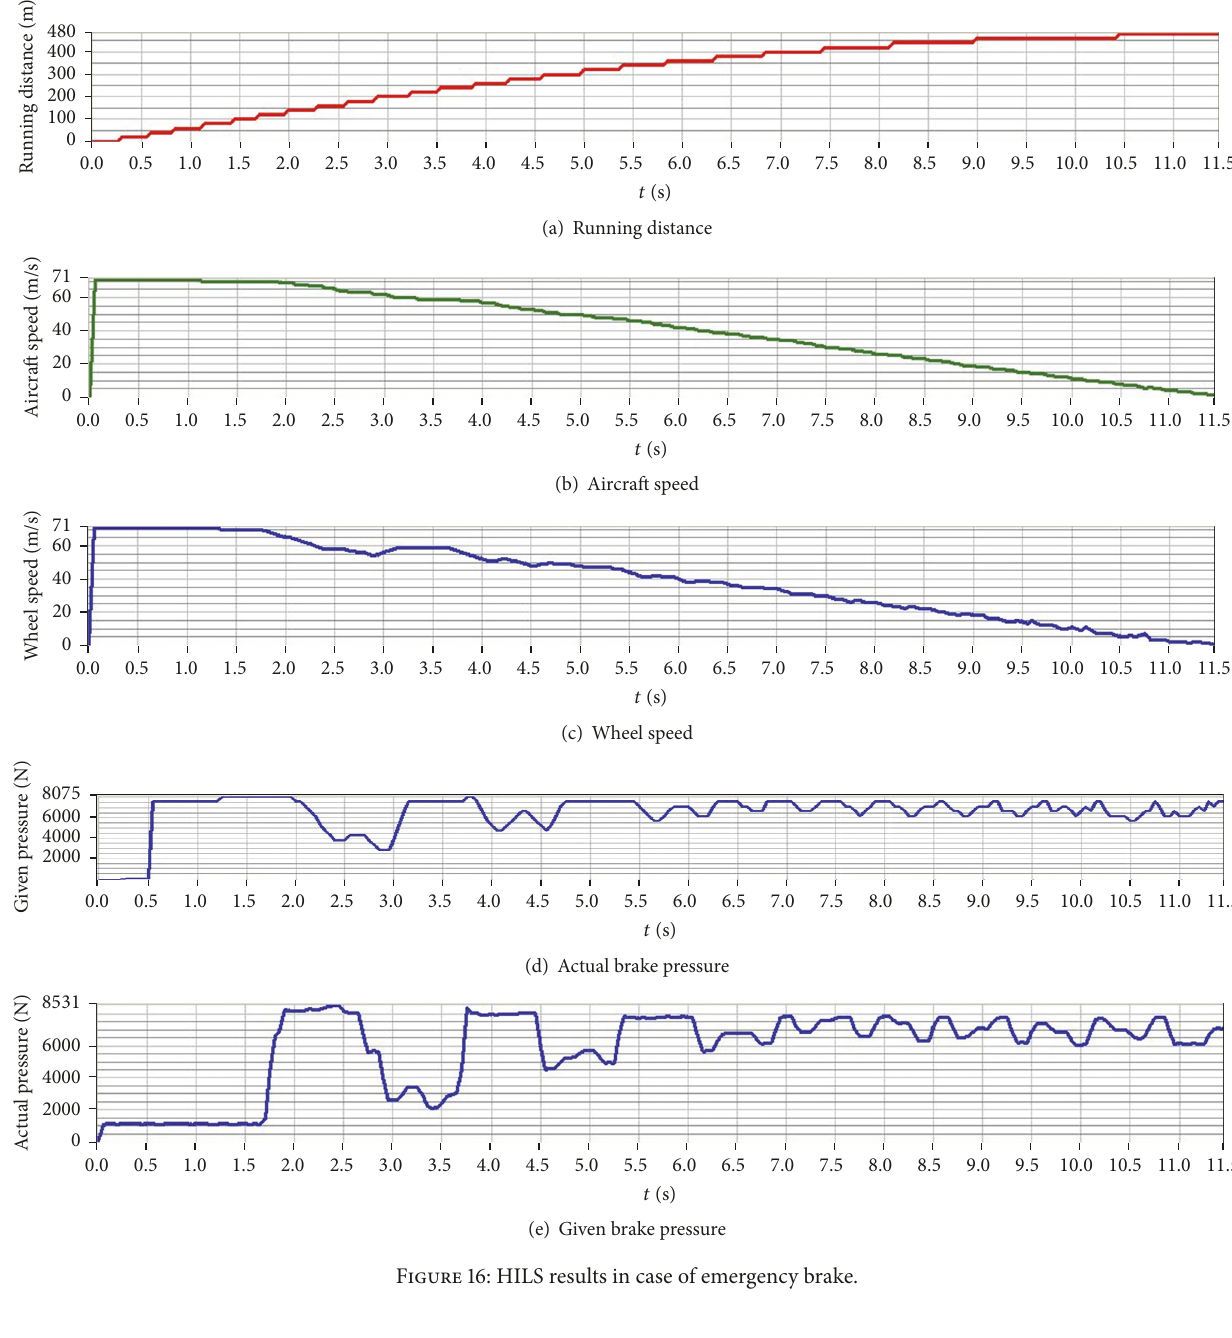
Figure 16: HILS results in case of emergency